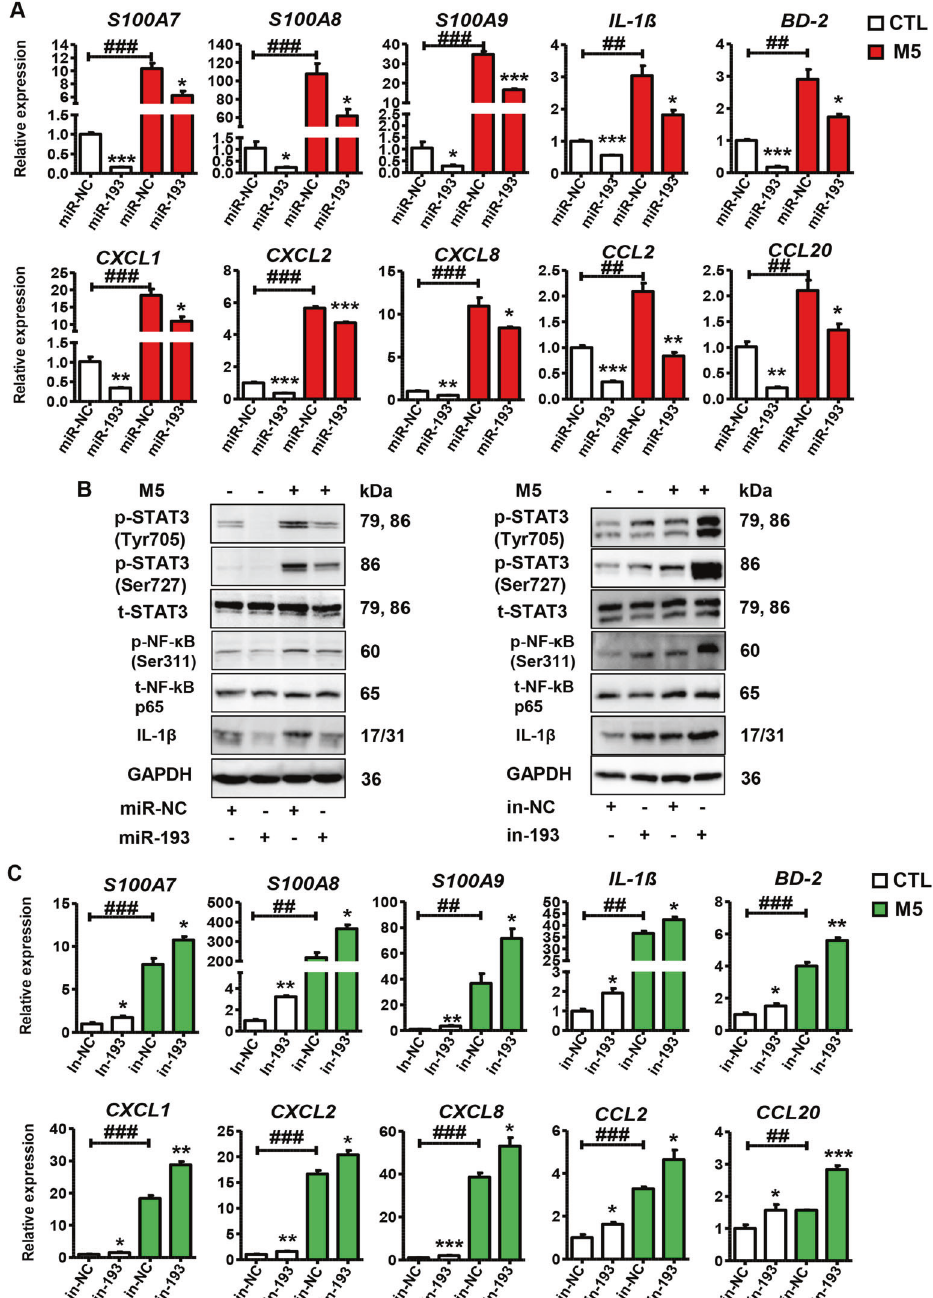
Fig. 2 Function of miR-193b-3p in M5-induced HaCaT cells. A Expression levels of psoriasis-related genes and in fl ammatory genes in HaCaT cells transfected with miR-193b-3p mimics (miR-193)/control (miR-NC) in the presence or absence of M5 treatment. mRNA levels were analyzed using qRT-PCR. GAPDH was used as the internal control. Each bar represents mean ± SEM ( n = 3). *** P < 0.001, ** P < 0.01, * P < 0.05, ### P < 0.001, ## P < 0.01, compared with the indicated controls. B Representative blots showing the levels of phospho-STAT3 (Tyr705), phospho- STAT3 (Ser727), phospho-NF- κ B p65 (Ser311), IL-1 β , etc. in HaCaT cells transfected with miR-193b-3p mimics (miR-193) or miR-193b-3p inhibitors (in-193) and their indicated CTLs (miR-NC/in-NC) in the presence or absence of M5 treatment. Protein levels were detected by western blotting. GAPDH was used as a protein loading control. C Expression levels of psoriasis-related genes and in fl ammatory genes in HaCaT cells transfected with miR-193b-3p inhibitors (in-193)/control (in-NC) in the presence or absence of M5 treatment. mRNA levels were analyzed using qRT-PCR. GAPDH was used as the internal control. Each bar represents mean ± SEM ( n = 3). *** P < 0.001, ** P < 0.01, * P < 0.05, ### P < 0.001, ## P < 0.01, compared with the indicated controls.